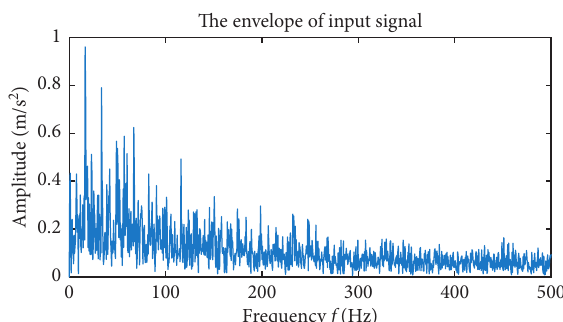
Figure 9: Envelope spectrum of intershaft bearing outer ring fault